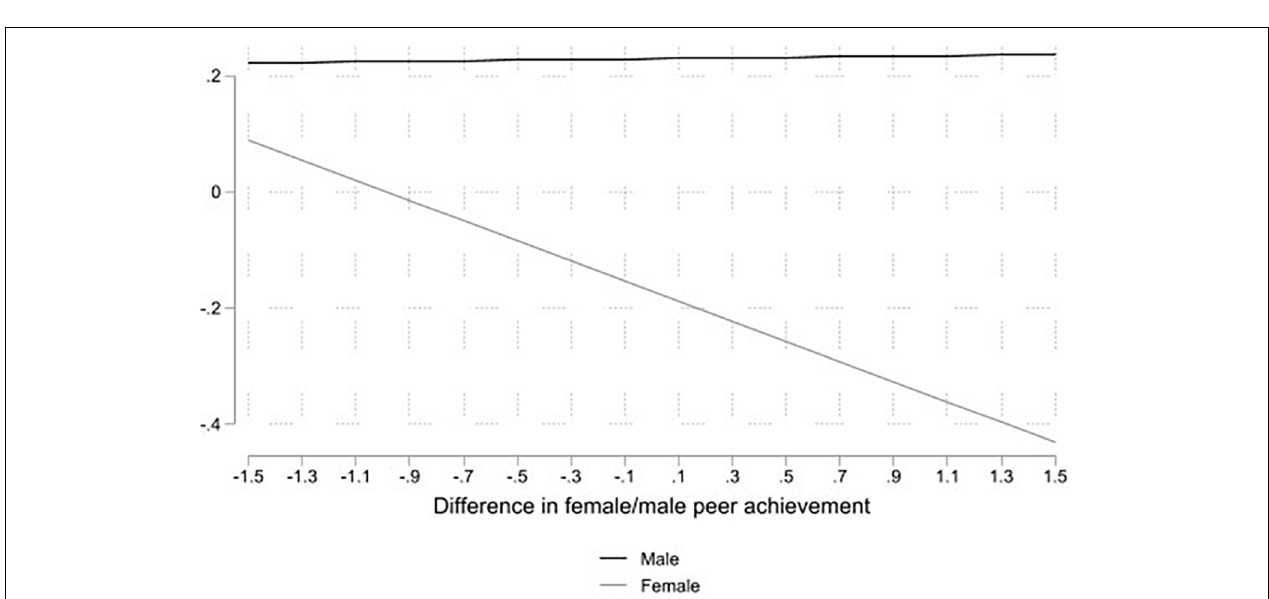
FIGURE 2 | Students’ GSB and predicted mathematics self-concept by gender. Marginal effects of teacher GSB on mathematics self-concept by gender. Based on estimates from Model 6 in Table 3 .